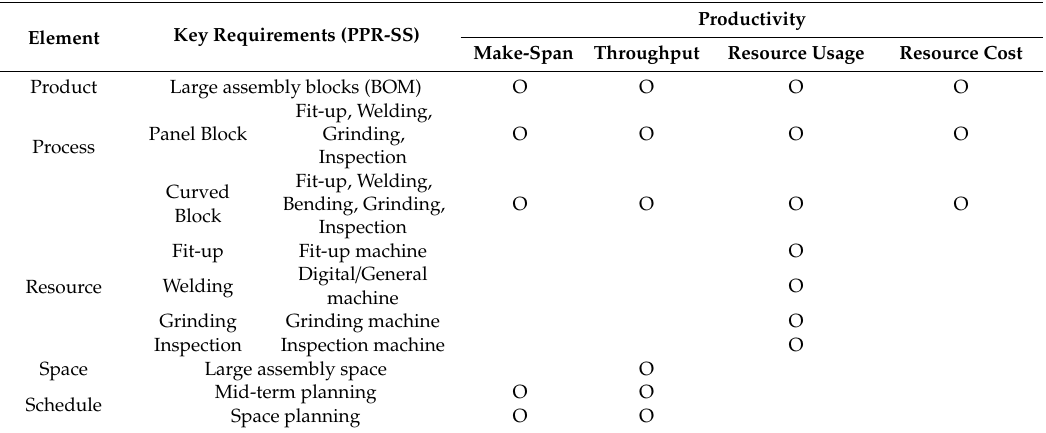
Table 1. The product, process, resource, schedule, and space (PPR-SS) information and productivity based on the PPR-SS. BOM: bill of materials. Element Key Requirements